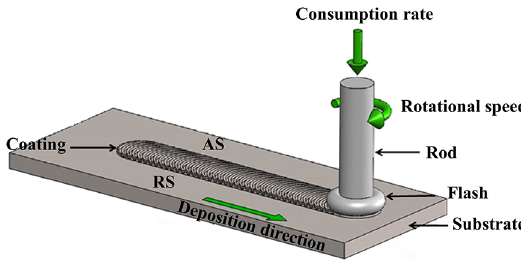
Figure 1. Schematic of FS 1